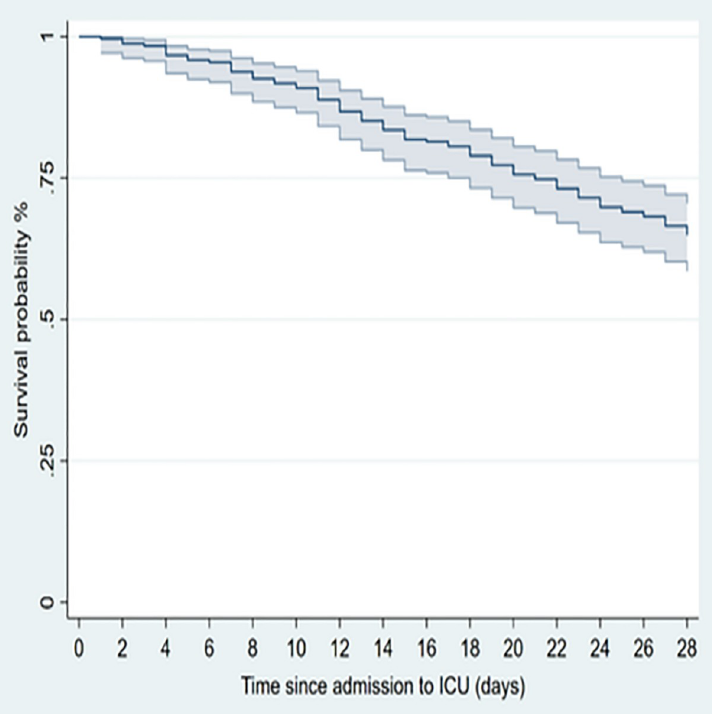
Fig 1. Survival of critically ill COVID-19 patients with pneumonia after the admission to the intensive care unit (ICU). Dashed lines represent 95%